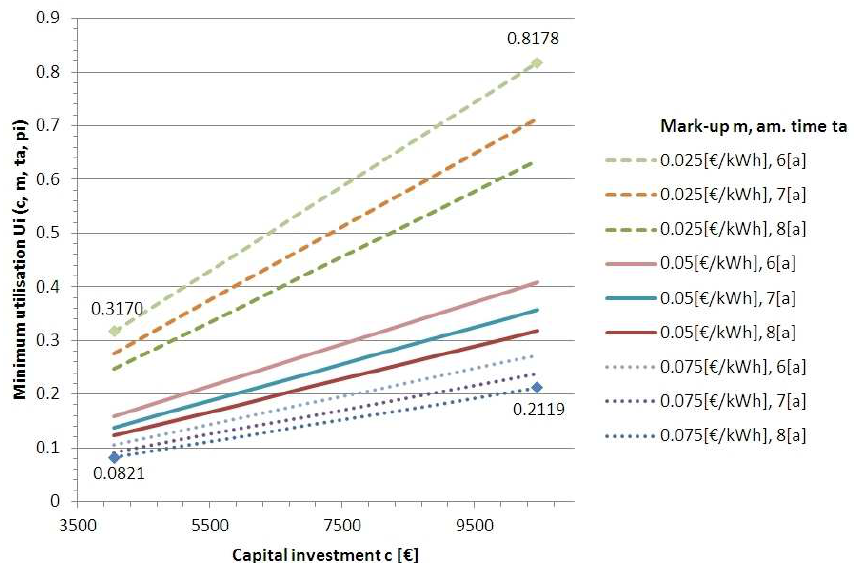
Figure 3. Minimum utilisation U i of a charging station for charging power p i =11kW and different combinations of parameters c, m, and t a